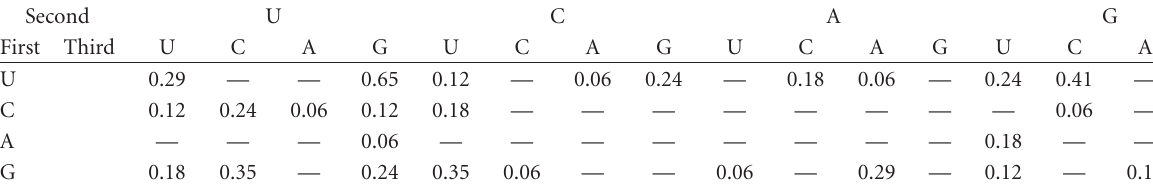
Table 2: Frequency of each triplet after subtraction (a) .